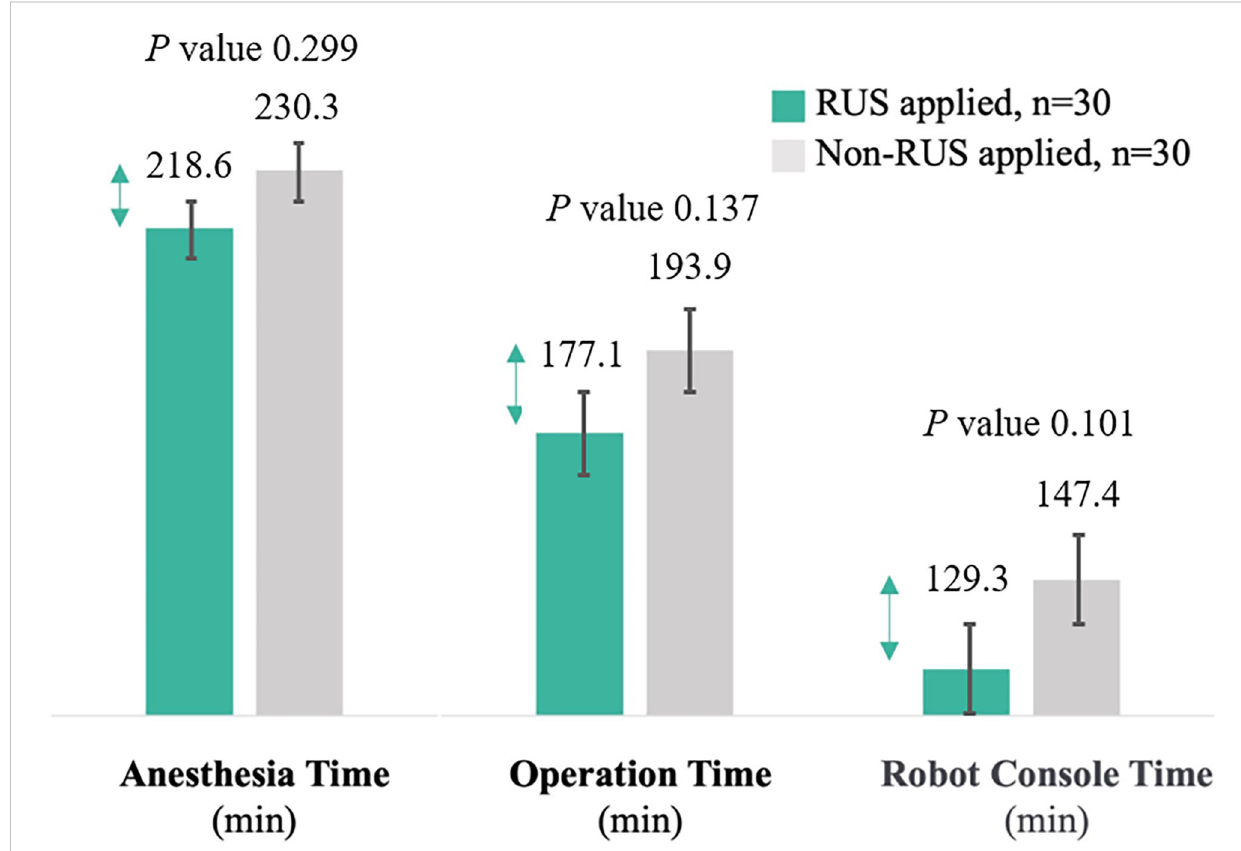
FIGURE 3 Comparison of anesthesia, operation, and console time between the experimental and control group (Error bars are used on graphs to indicate the standard